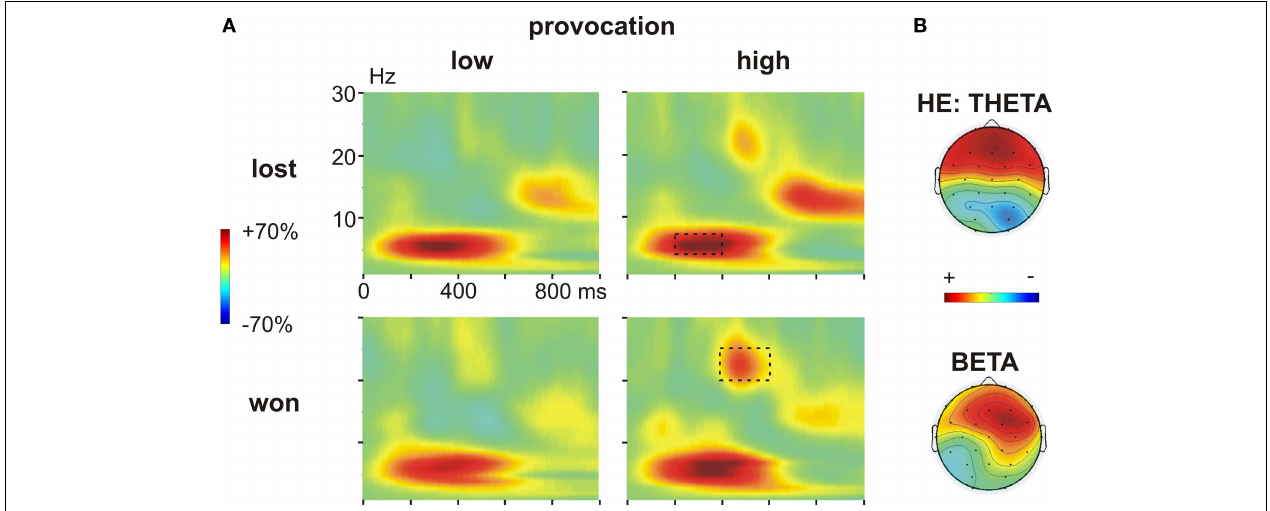
FIGURE 5 | Time frequency results outcome phase. (A) Changes in power (%) relative to the baseline (100 ms before the feedback) in low (left panel) and high (right panel) provocation trials at the frontal electrode Fz, separately for lost (upper row) and won (lower row) trials. Highlighted are the analyzed frequency and time ranges of the theta (4–6 Hz, 200–400 ms) and beta (20–25